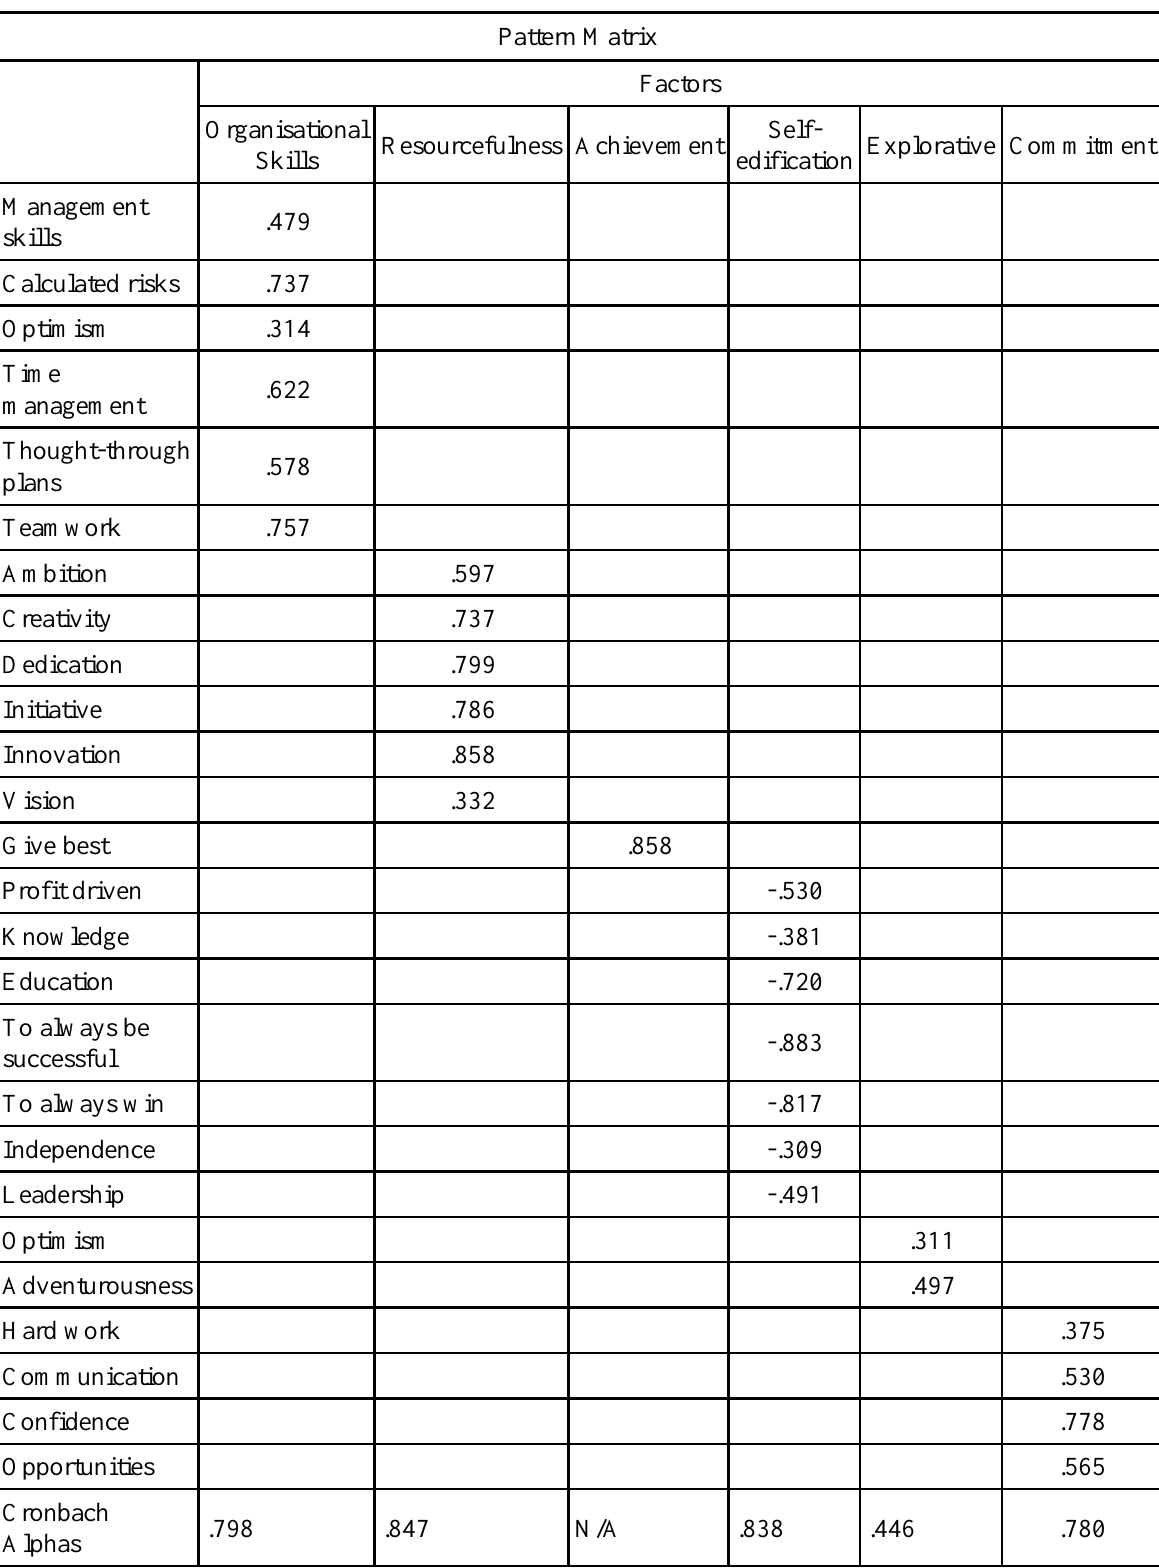
Table 3: Results of the factor analysis